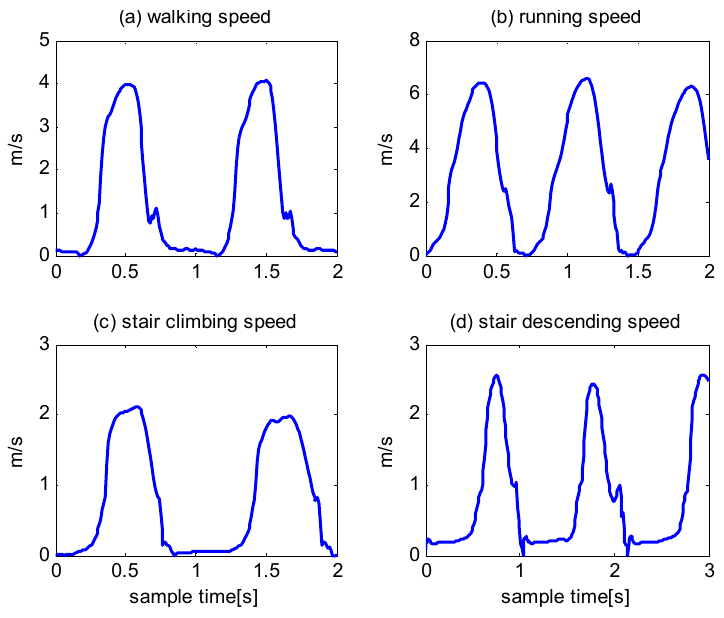
Figure 3. Norm of velocity for different types of gait.